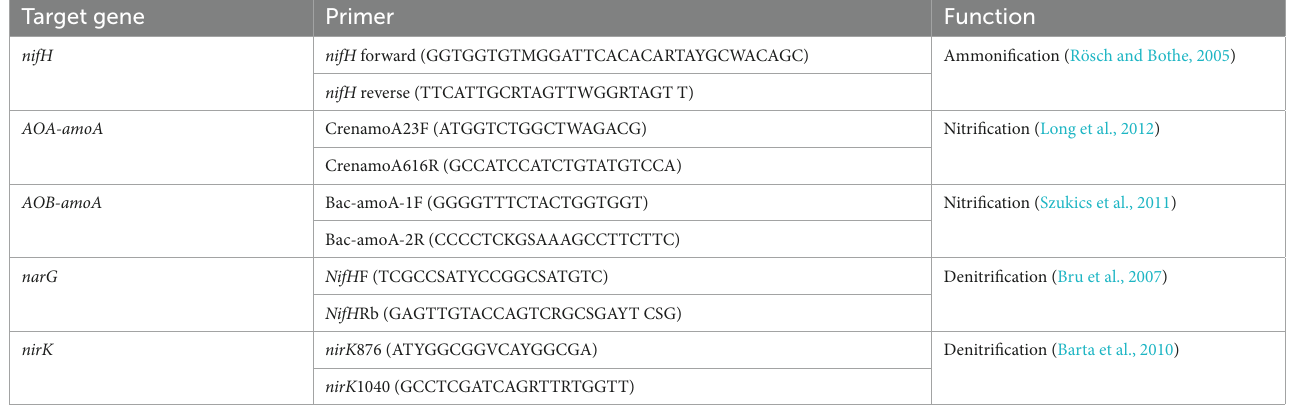
TABLE 1 The primer sets for the amplification of functional genes involved in the nitrogen cycle. Target gene